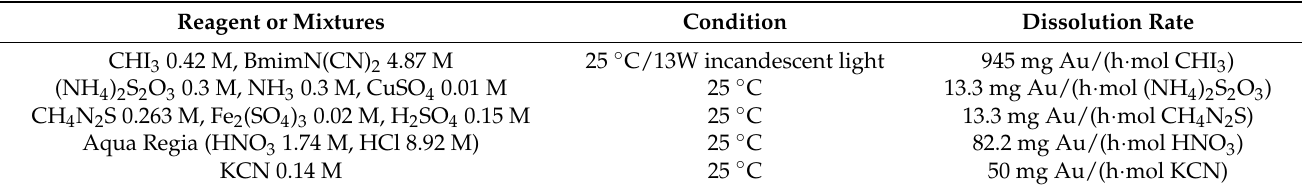
Table 2. Comparison of gold dissolution rate with other methods in literature [26].